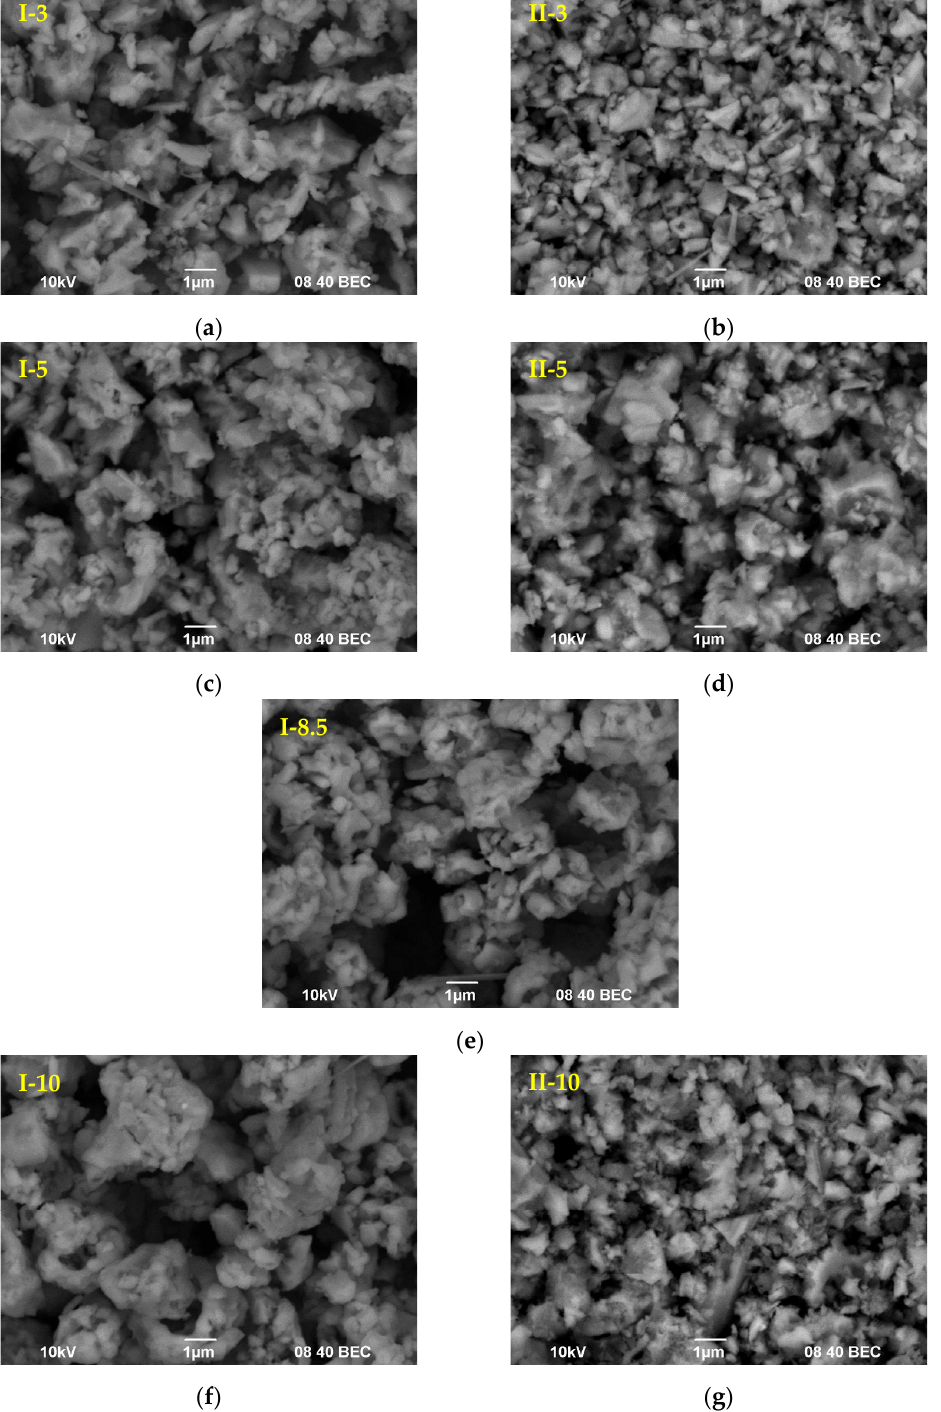
Figure 1. SEM images of the powder mixture with different amounts of the sintering additive: ( a , b ) 3% wt.; ( c , d ) 5% wt.; ( e ) 8.5% wt.; ( f , g ) 10%